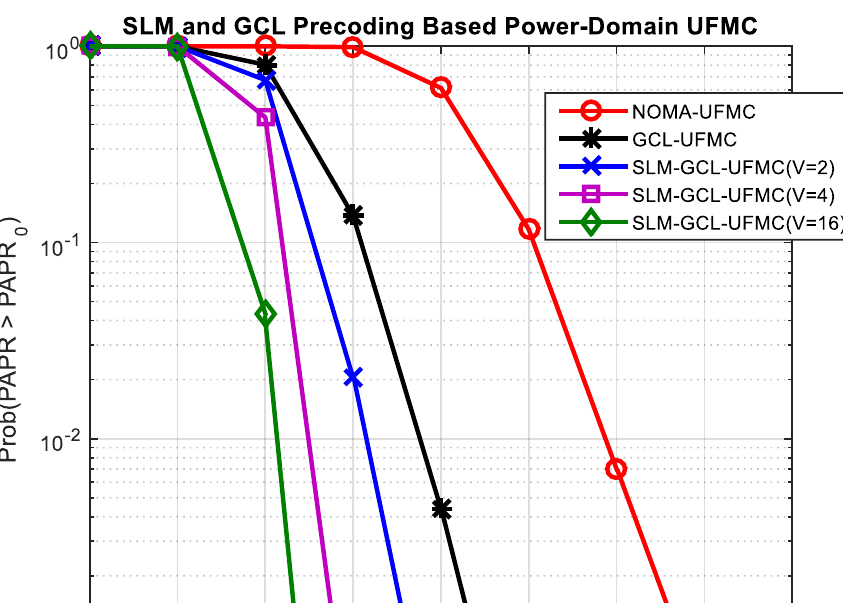
Figure 4. PAPR analysis using 16-QAM.